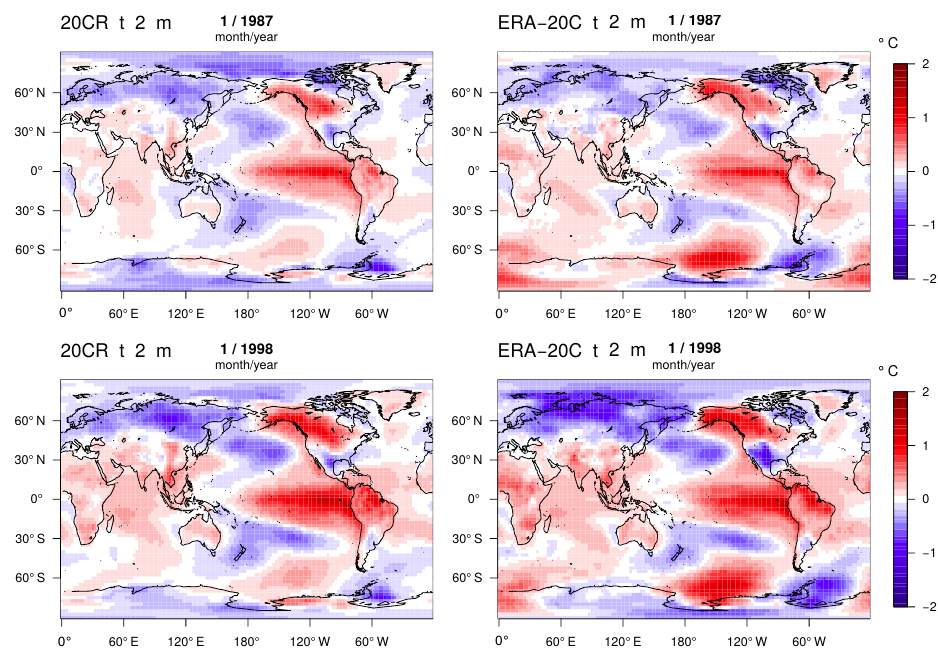
Figure 3. Global patterns of 2m temperature for the components 3, 4, 7 and 8 in 20CR (left column) and ERA-20C (right column). Snapshots are taken from January 1987 (top row) and January 1998 (bottom row). Unit ◦